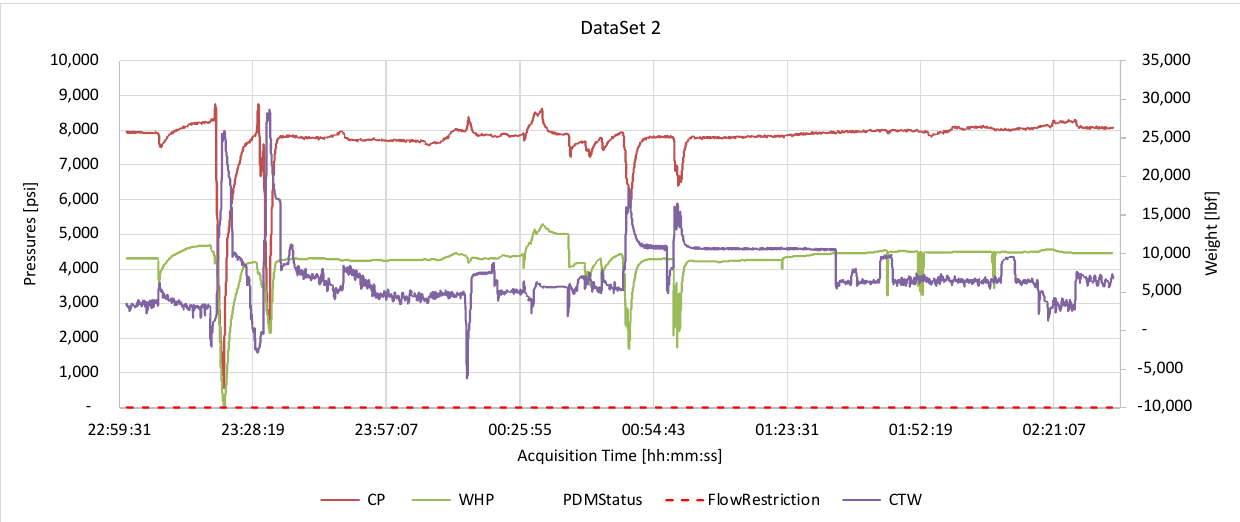
Figure 11. Plot for Dataset 2 datapoints and FIS outputs.